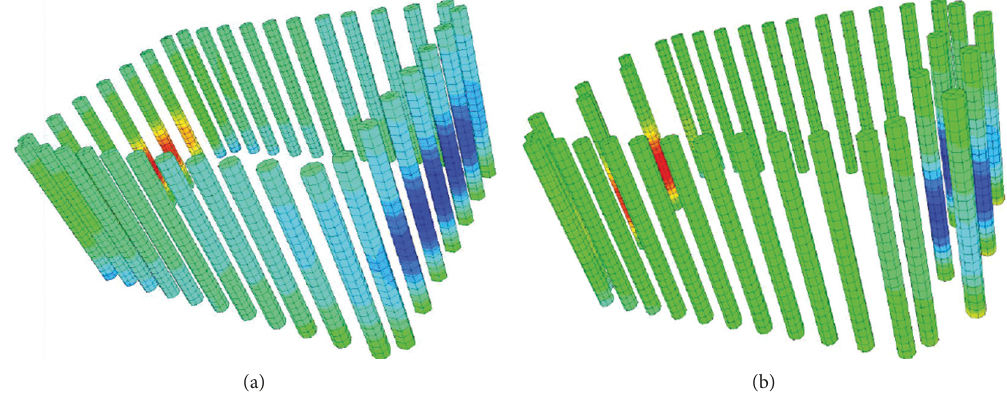
Figure 13: Pile deformation cloud map. (a) Single-row pile. (b) New pile